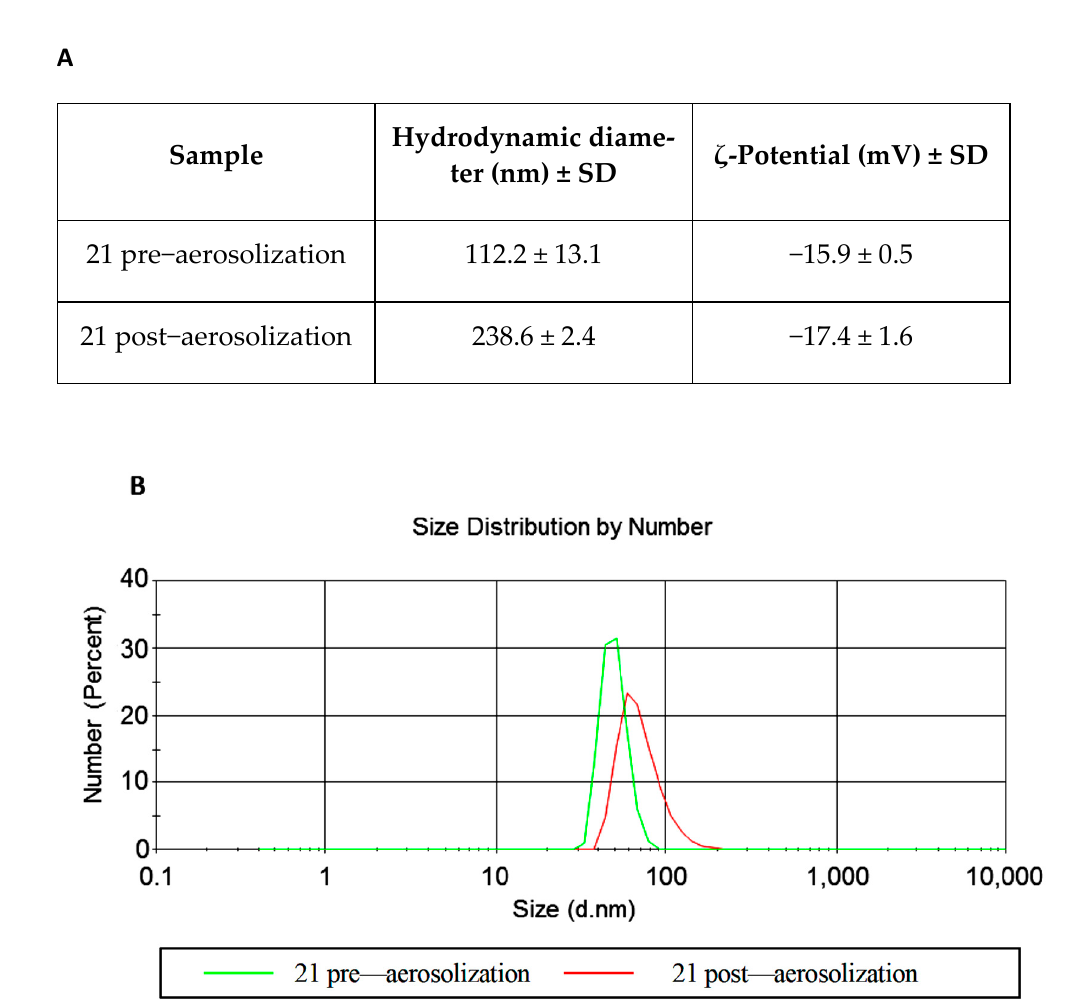
Figure 5. (Panel A ): hydrodynamic diameter and ζ -potential evaluation, pre- and post-aerosolization of sample 21 (post sonication); (Panel B ): size distribution profile pre- and post-aerosolization of sample 21 (post sonication). Table 3. E. coli strains: biofilm formation ability. See ref. [41]. Multi drug resistance (MDR) ≥ 3 different antibiotic classes. Number (%)